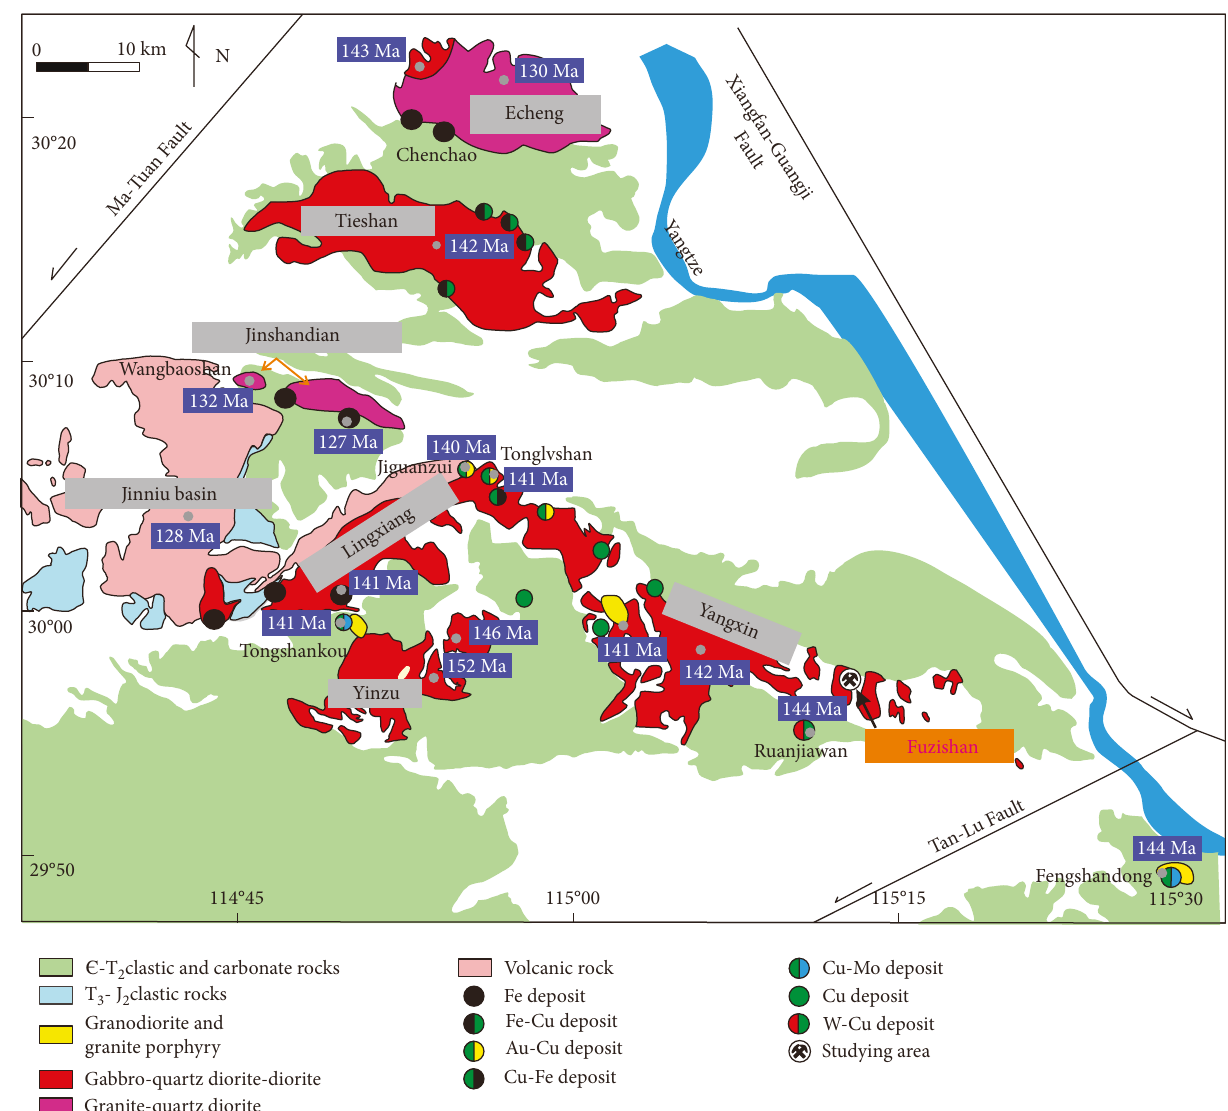
Figure 2: Geological map of the Edong district, southeast Hubei Province, the west most part of the MLYRMB (modi fi ed after